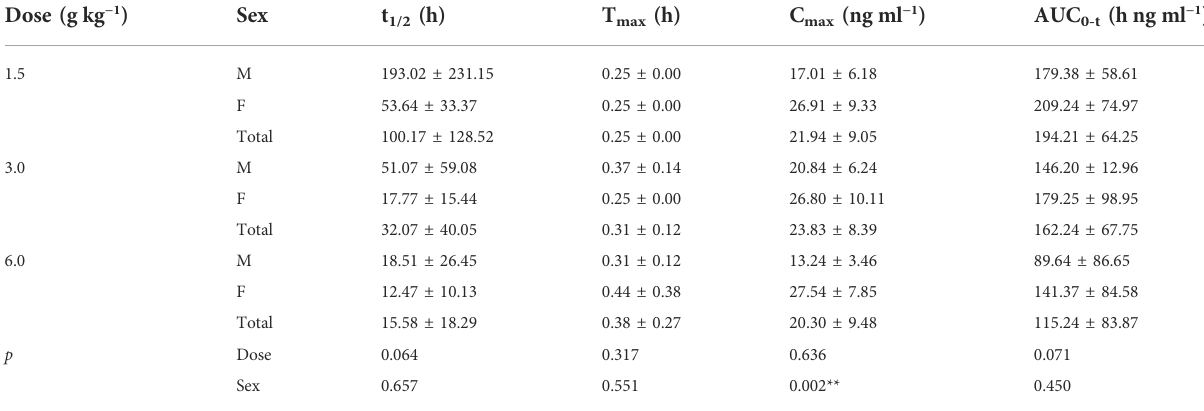
TABLE 10 Pharmacokinetic parameters of ferulic acid after different doses of TYZB in rats (D1). Dose (g kg − 1 ) Sex t 1/2 (h) T max (h) C max (ng ml − 1 ) AUC 0-t (h ng ml − 1 ) 1.5